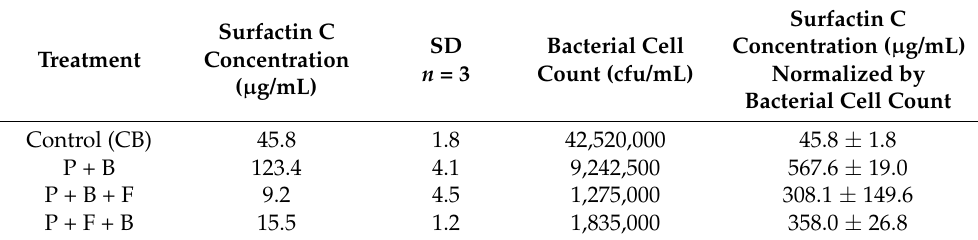
Table 1. Quantitative data for surfactin production in each of the treatments.